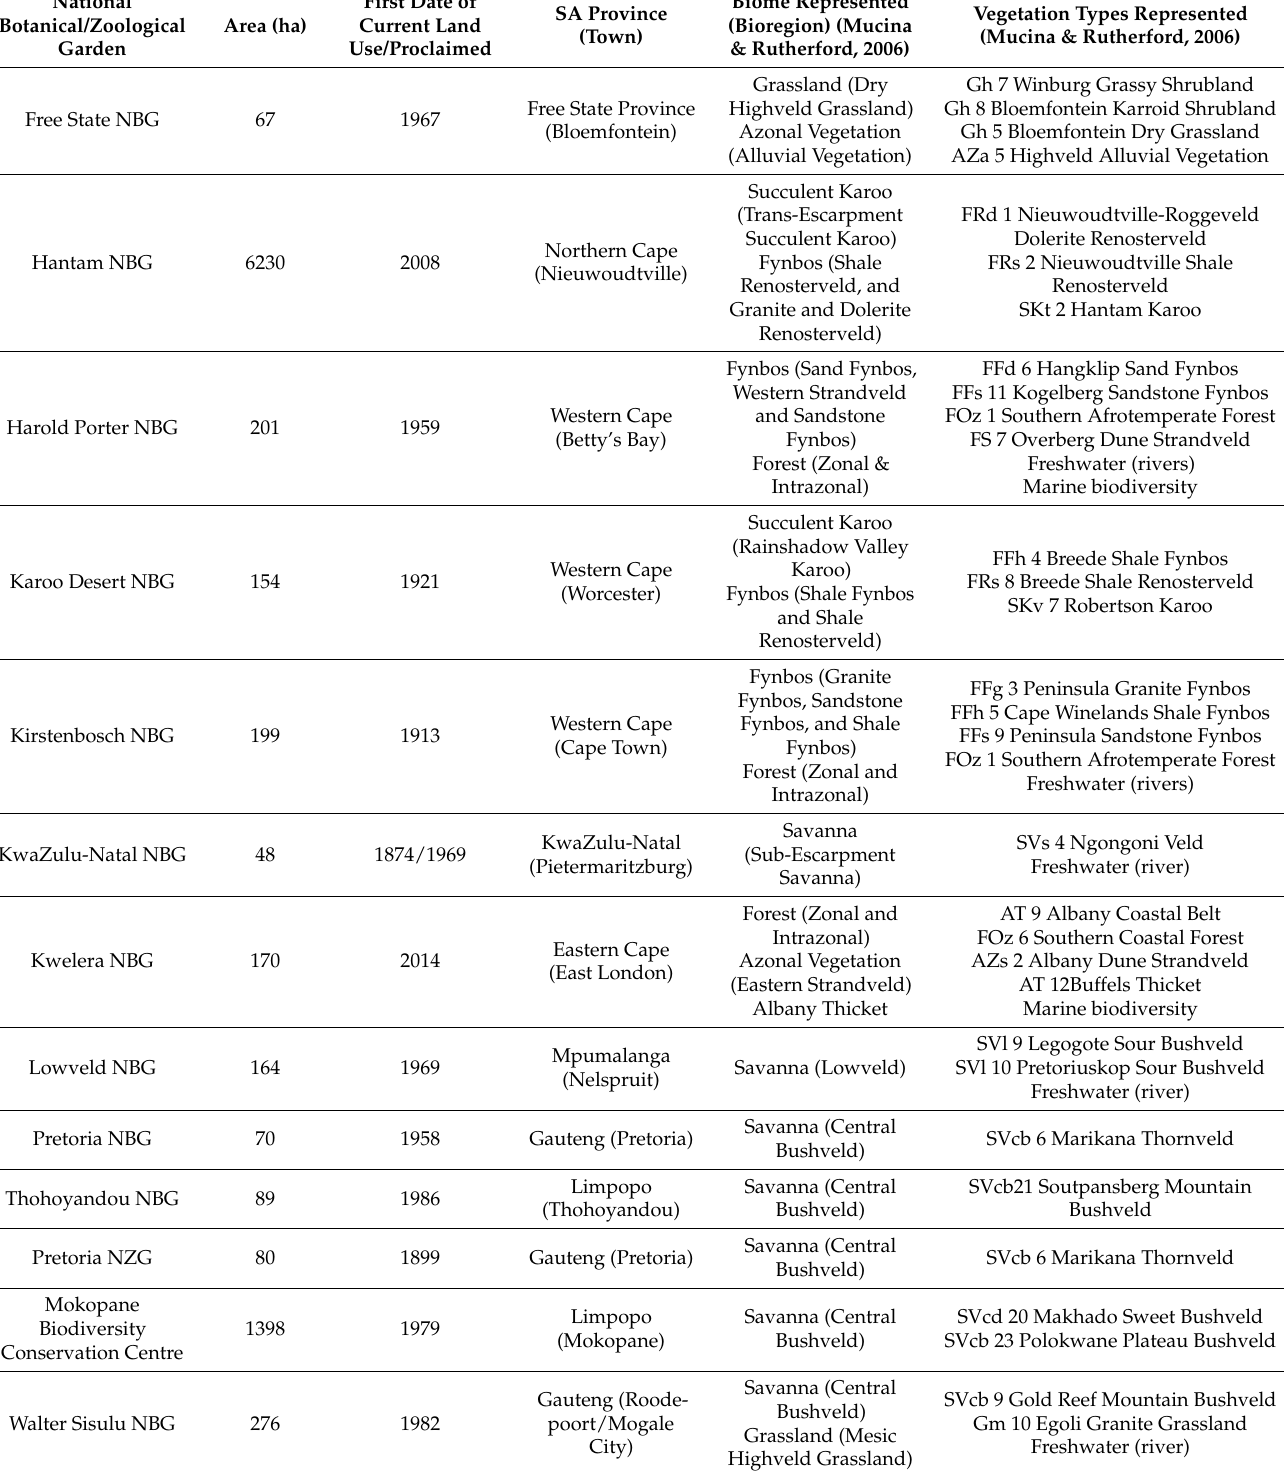
Table 1. SANBI botanical and zoological gardens’ features: area, the first date of current land use/proclaimed, biomes and preserved vegetation